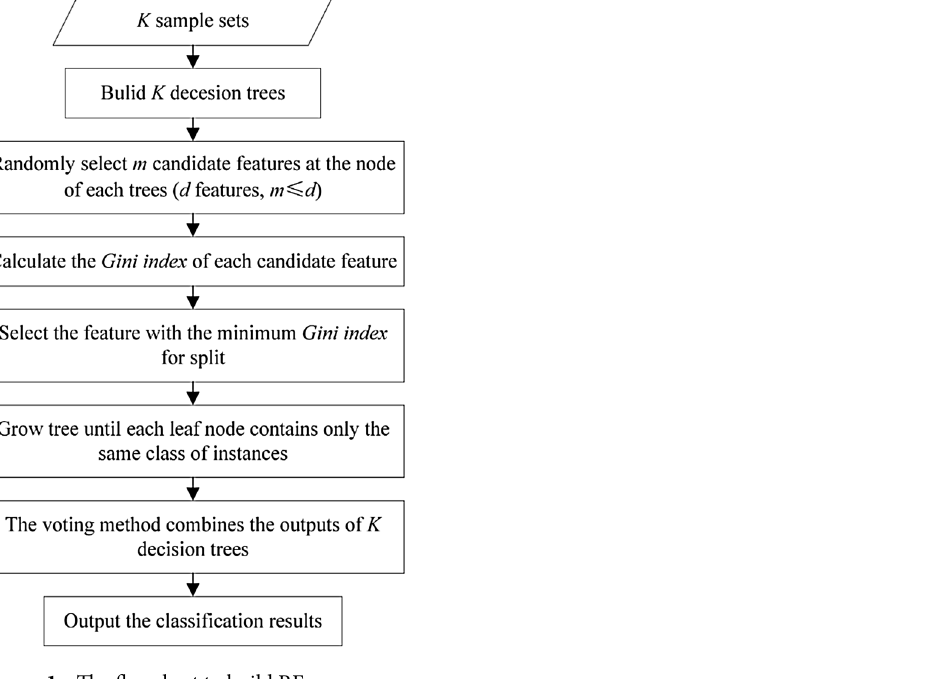
Figure 1. The flowchart to build